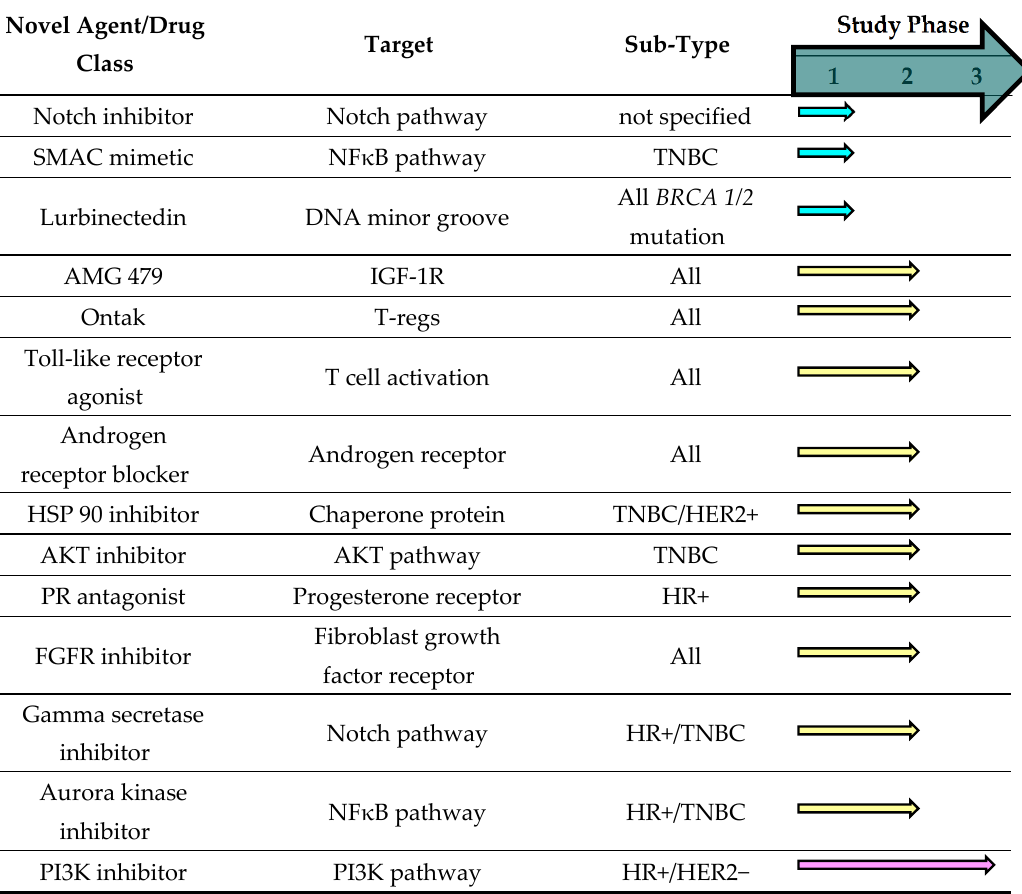
Table 5. Evolving novel agents [16].